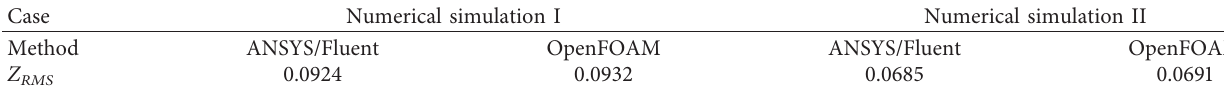
Table 9: RMS of heave response by ANSYS/Fluent and OpenFOAM.